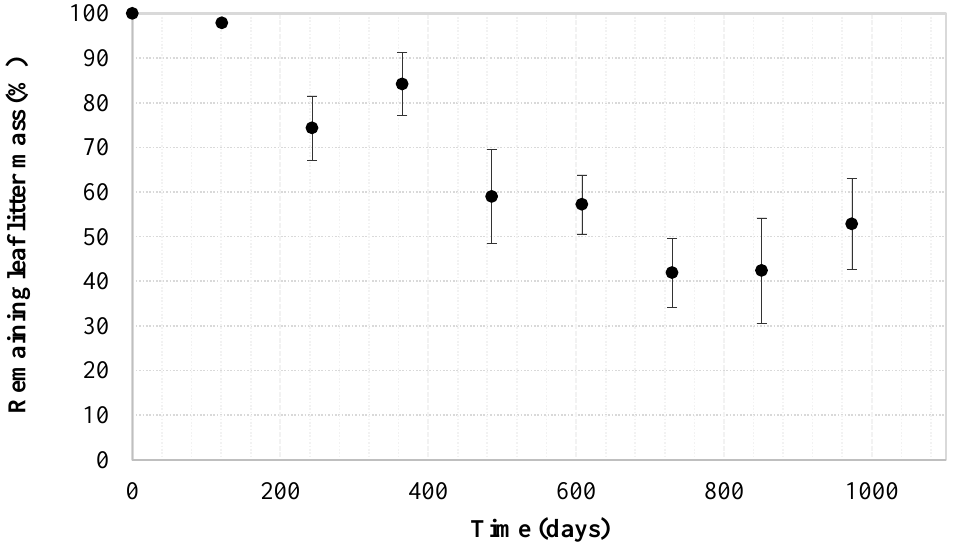
Figure 1. Meteorological conditions during the decay assay. P: Precipitation, MMT: Mean maximum temperature, MmT: Mean minimum temperature, MT: Mean temperature.